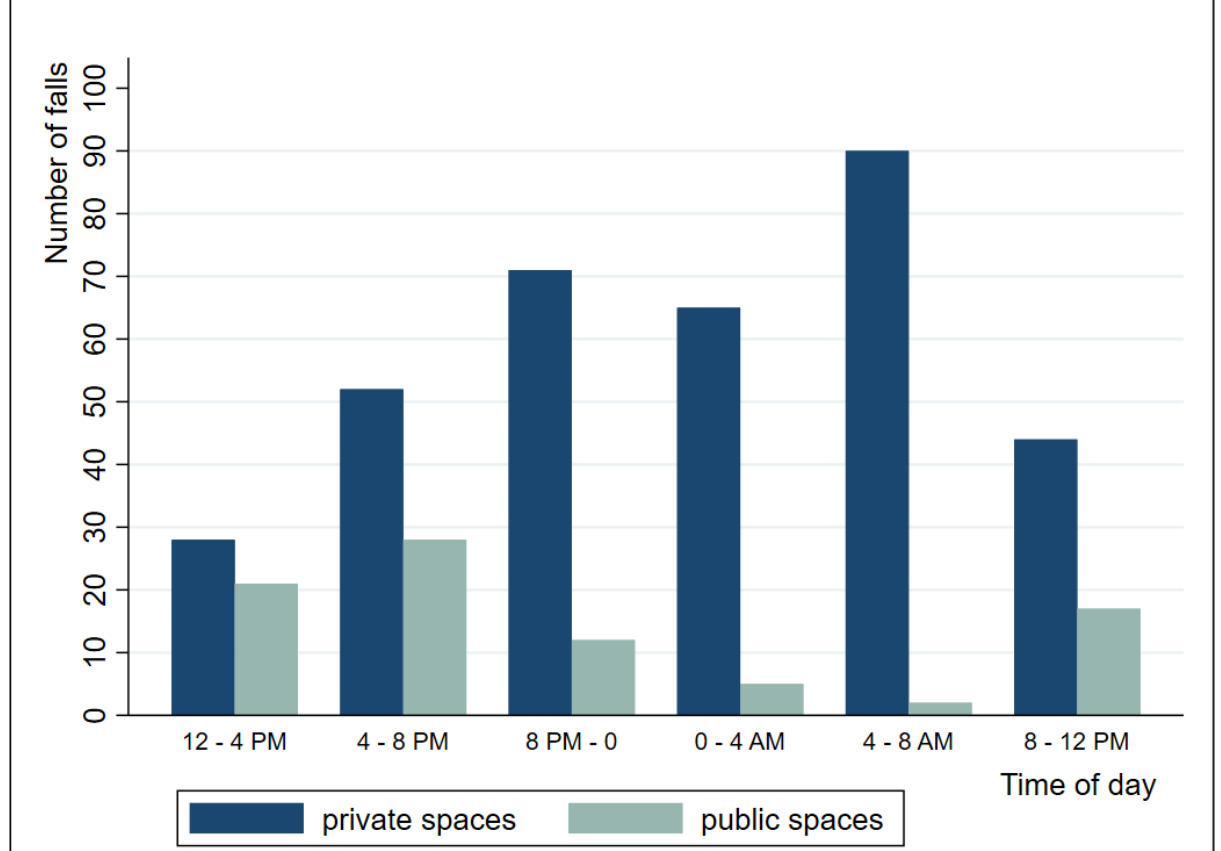
Figure 3. Display of falls according to location and day schedule. Private spaces refer to residents' personal areas (ie, individual’s bedroom